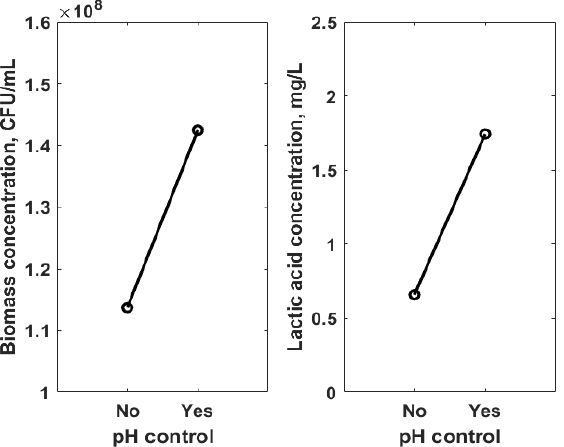
Figure 5. ANOM results for the bacterial growth ( left side ) and lactic acid production ( right side ).